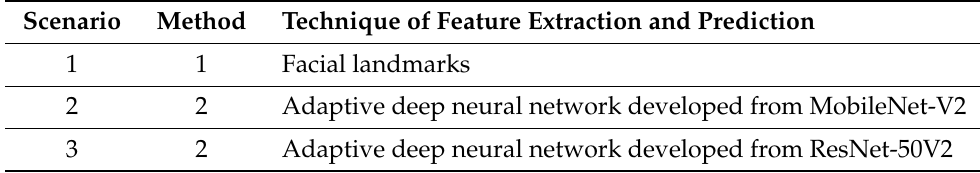
Table 3. Scenarios of the proposed methods for